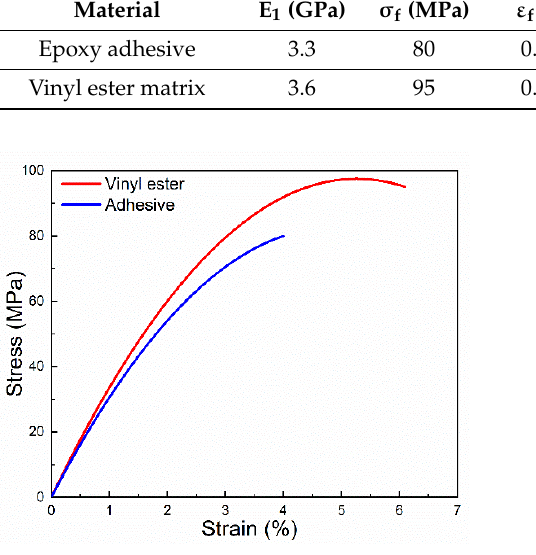
Table A1. Values from the manufacturer’s datasheet for adhesive and matrix, and the determined values of E 0 and α .